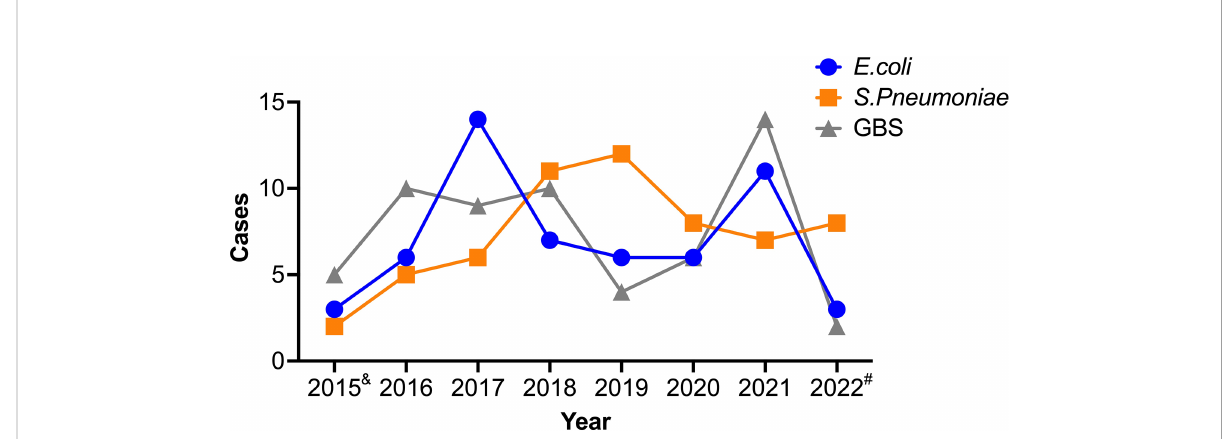
FIGURE 4 Trends of three etiological causes of BM. The information of patients was collected and the case number in each year was analyzed for the three infectious BM. &, data represent May to Dec of 2015. #, data represent Jan to May of